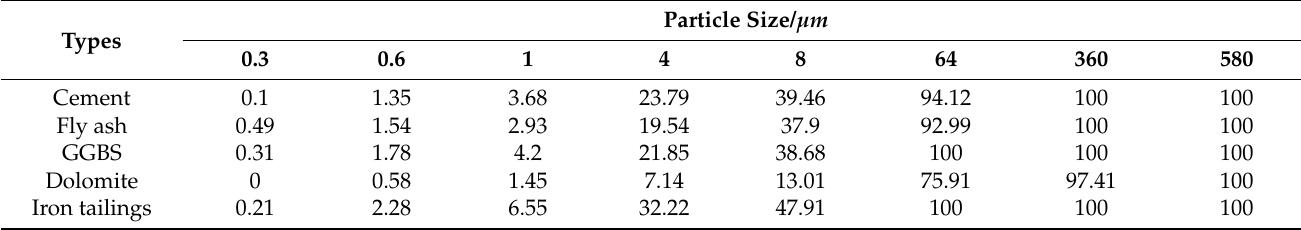
Table 1. Particle passing percentage of the cementitious materials/%.